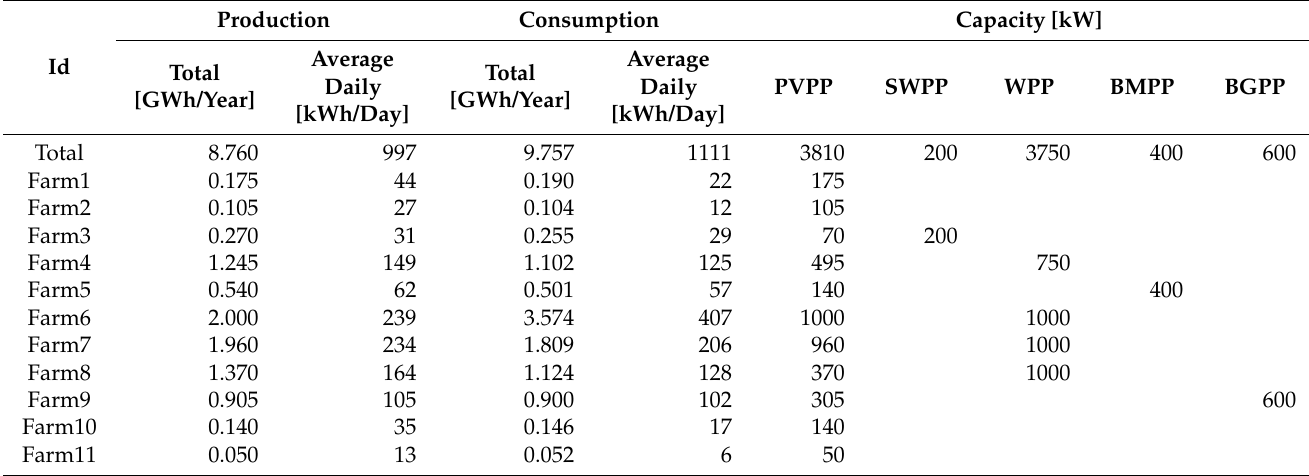
Table 4. Characteristics of the sources and obtained results of generation